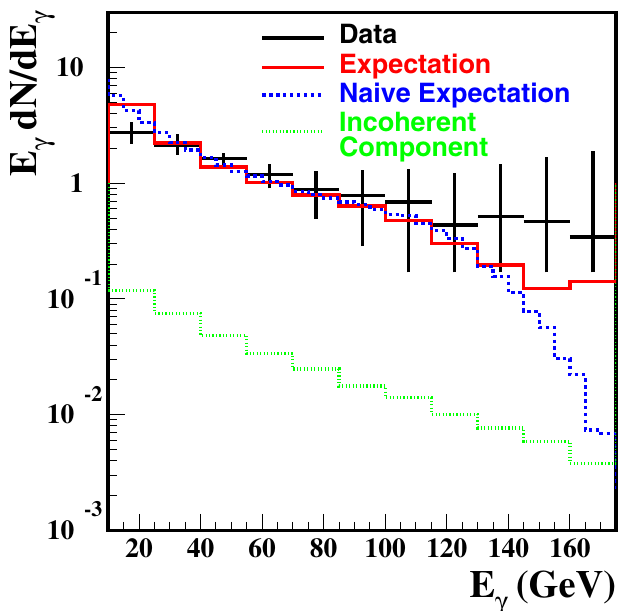
dN=dE FIG. 23. (Color) Photon power yield, E , as a function (cid:1) (cid:1) of individual photons radiated by an electron of the energy E (cid:1) beam of 178 GeV in the SOS-aligned 1.5 cm Si crystal. The black crosses are the measurements with the pair spectrometer, the vertical lines represent the errors including the uncertainty in the acceptance of the spectrometer. The red solid histogram represents the Monte Carlo prediction for our experimental conditions. The green dotted line represents the small contribu- tion due to incoherent interactions. For completeness, we also show the theoretical predictions if the experimental effects are ignored (blue dashed